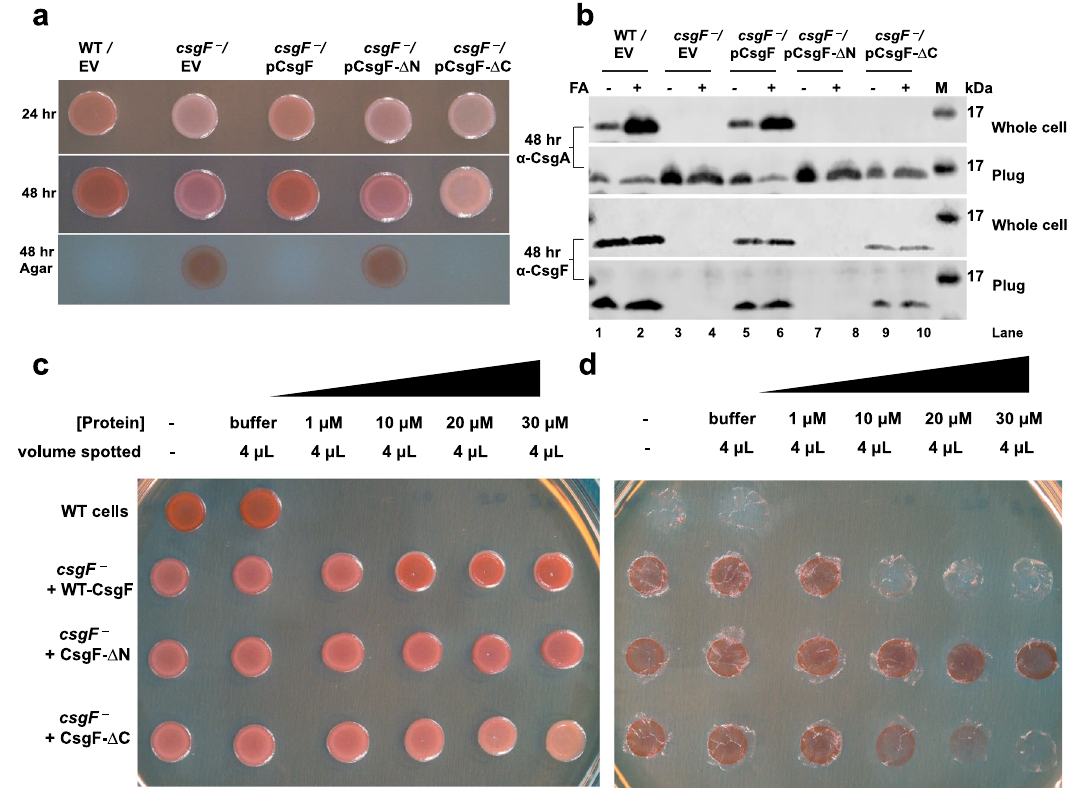
Fig. 3 | Exogenous CsgF complements csgF ‒ cells. a Cells were grown on Congo red (CR) indicator plate to assess the phenotypes of WT/Empty vector (MC4100/ pLR1), csgF ‒ /Empty vector (MHR592/pLR1), csgF ‒ /pCsgF (MHR592/pLR73), csgF ‒ / pCsgF- Δ N (MHR592/pCsgF- Δ N), and csgF ‒ /pCsgF- Δ C (MHR592/pCsgF- Δ C), and after 24 and 48h and agar plate after removing bacterial cells. EV: Empty Vector. b Western blots on whole cells and plugs after 48h of growth on YESCA (Yeast Extract Casamino acids) plates. The samples for blots were prepared either in 2X SDS-PAGErunningbufferdirectlyor fi